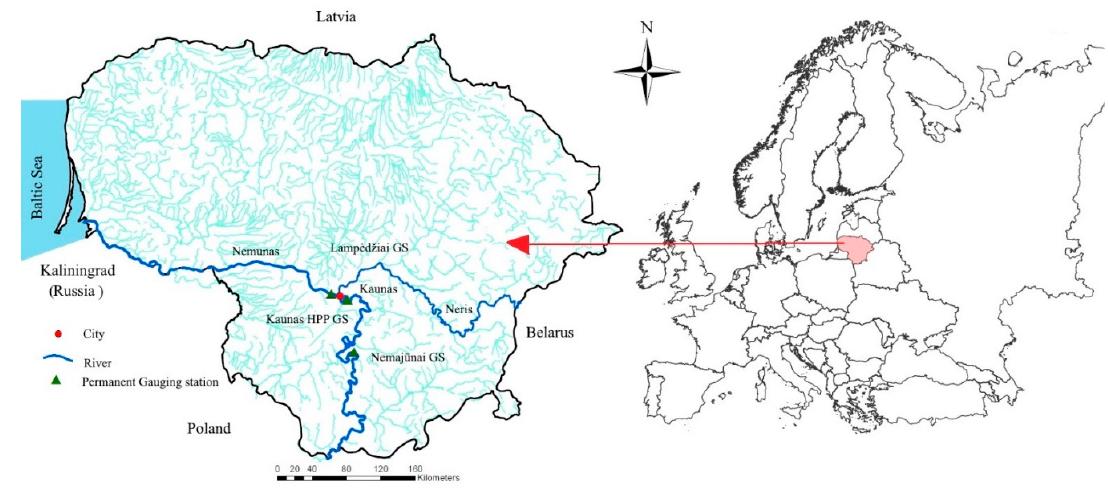
Figure 1. Nemunas River, Kaunas hydropower plant (HPP) and permanent gauging station (GS) locations.